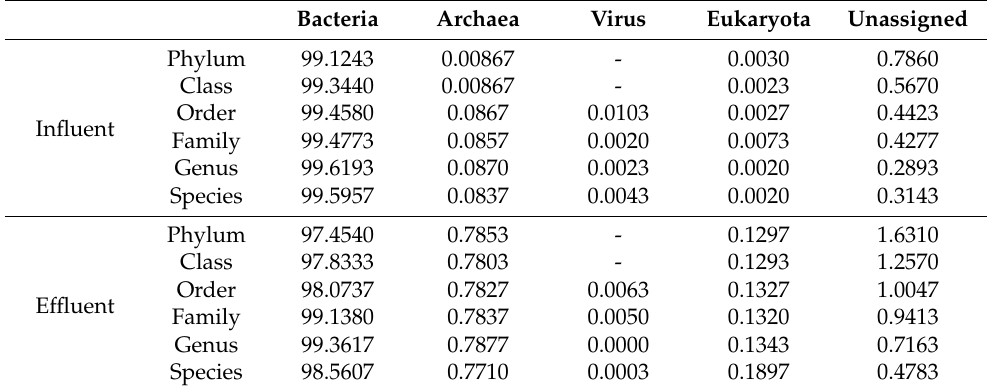
Table 1. Distribution of taxonomic units in influent and effluent samples a (%). Bacteria Archaea Virus Eukaryota